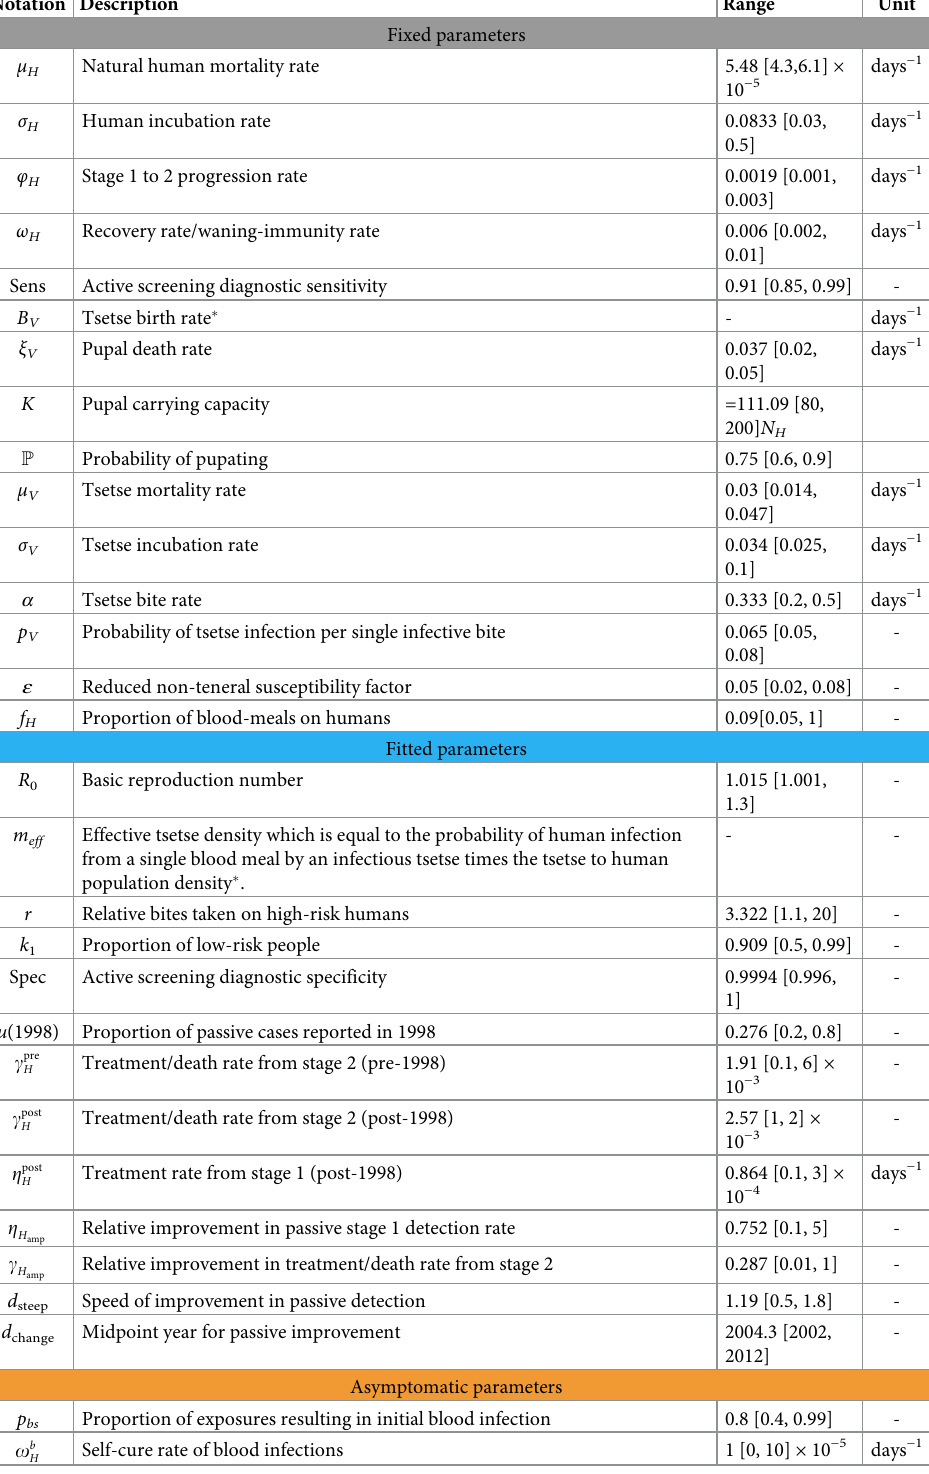
Table 1. Model parameters. Notation, description, and a range of all parameters used for sensitivity analysis. We split the list by those parameters that are typically considered as fixed in previous analysis of the baseline model, those that are featured in the baseline model but are fitted to data, and the five new parameters that are new to this asymptomatic model variant. We also show the one with the highest likelihood for the health zone